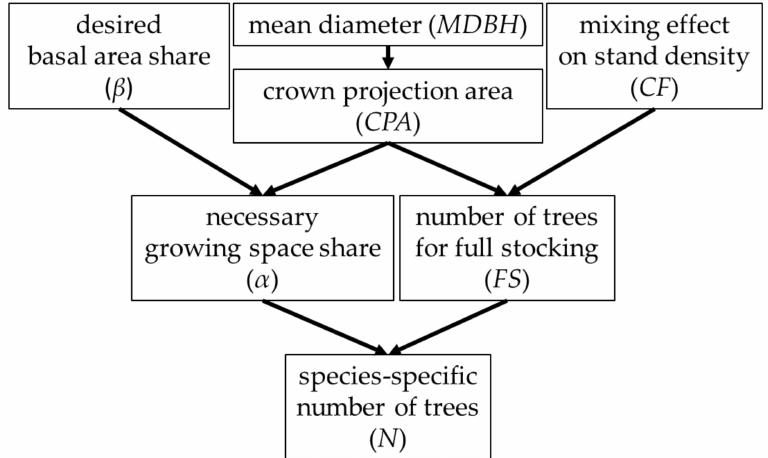
Figure 1. Conceptual diagram of the approach for the regulation of mixture proportion and of the computation of tree number guide curves. To obtain the number of trees ( N ), we filled the necessary growing space share ( α ) required for the desired basal area share ( β ) until full stocking. The number of trees per hectare for full stocking ( FS ) results from the species-specific crown projection area ( CPA ) and a correction factor ( CF ) for suitability in mixed species stands. The necessary growing space share results from the desired basal area share and the stand age dependent diameter ( MDBH ) related crown projection